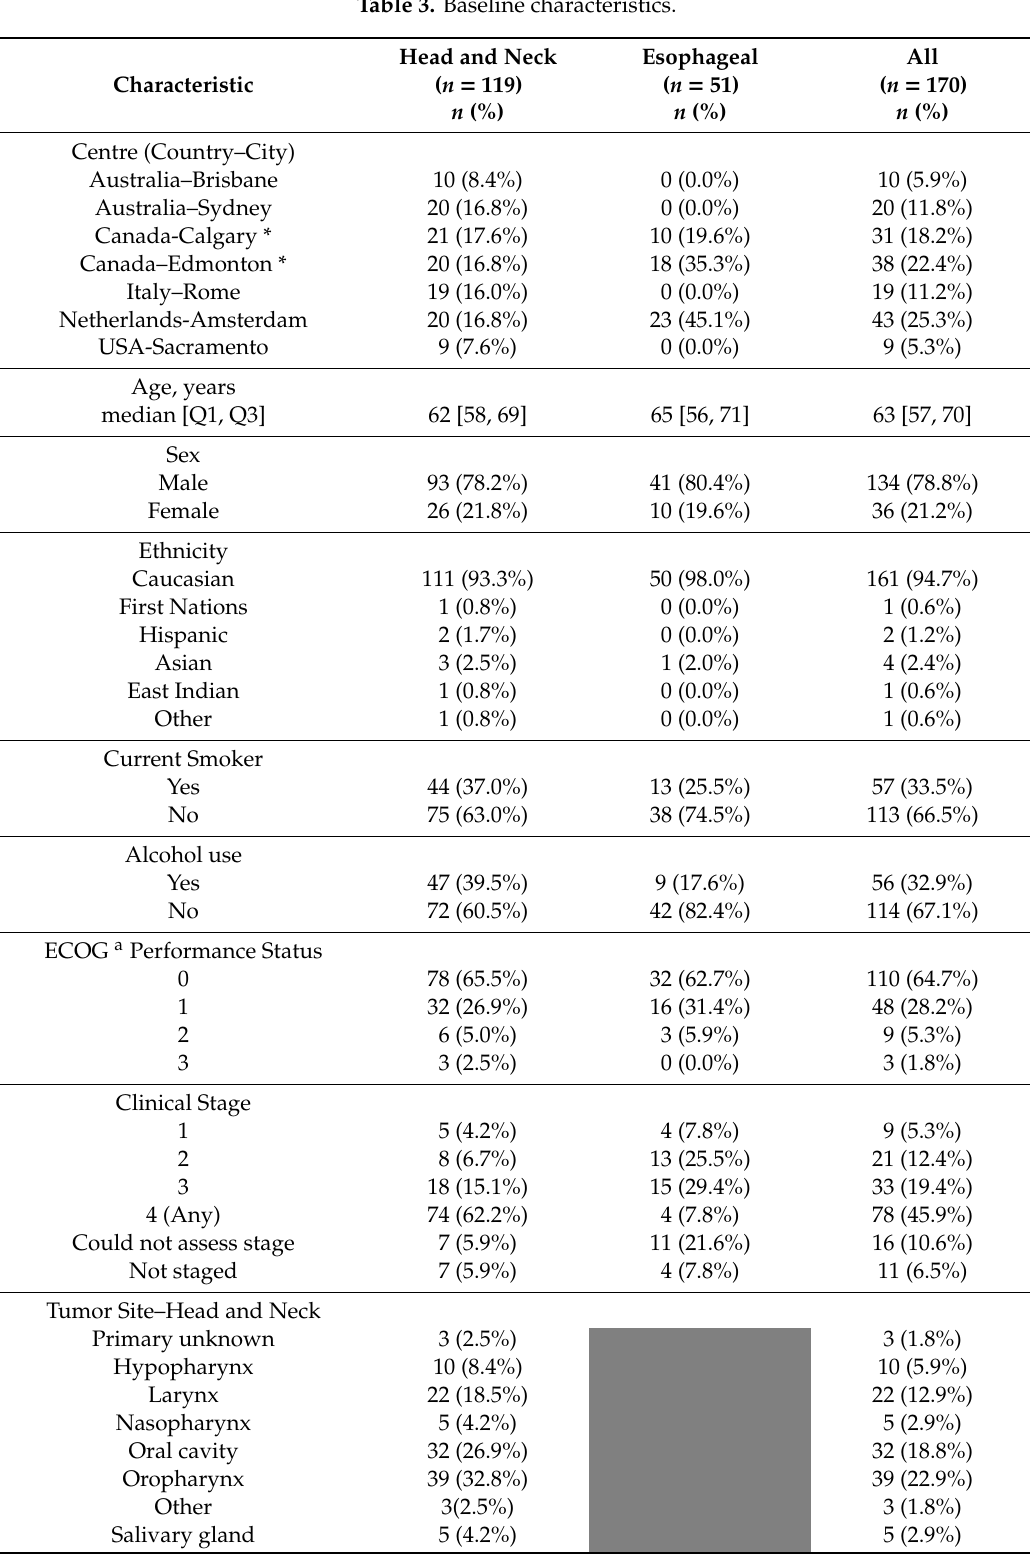
Table 3. Baseline